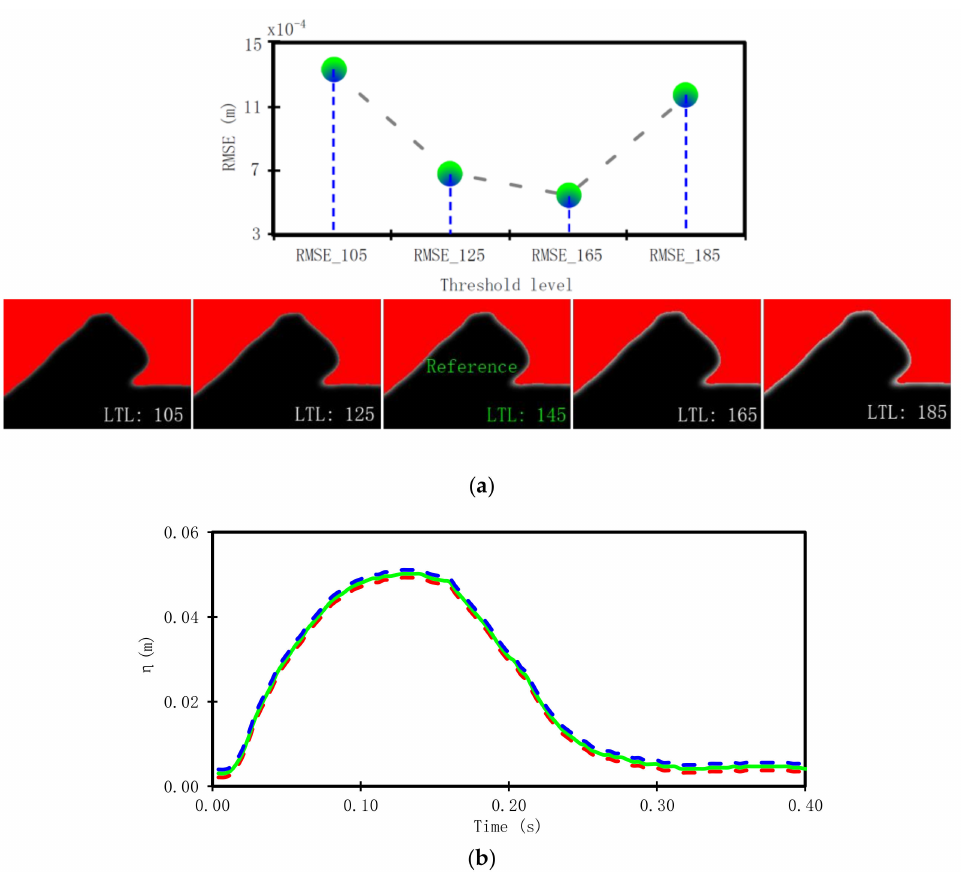
Figure A1. Possible error in measurements due to image binarization. ( a ) RMSE obtained for different threshold levels (LTL) before the binarization of the images. ( b ) Time series of water elevations by probe d2 in the first event of CE3. The solid line represents the measurements with LTL = 145. The dashed lines denote the range of possible error (mean RMSE) because of different LTL values in the image